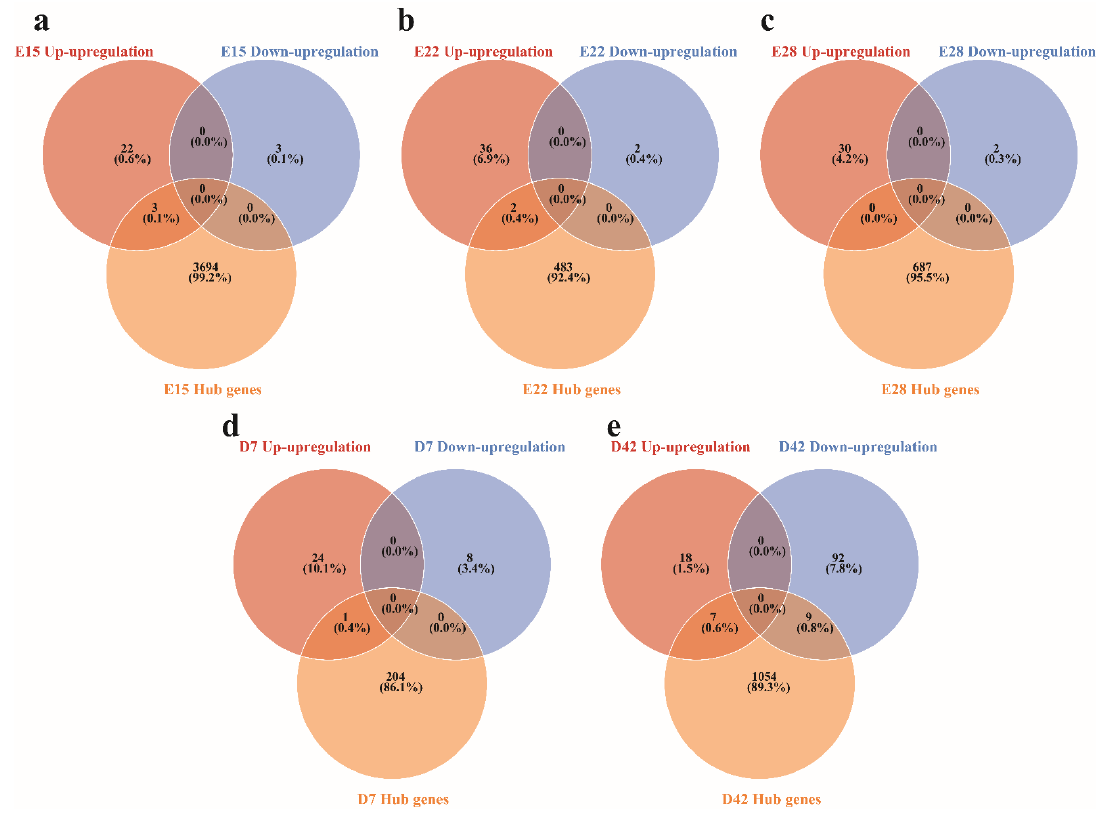
Figure 5. Genes associated with crest cushion in the different developmental stages. Venn analysis of DEGs and hub genes in the E15 ( a ), E22 ( b ), E28 ( c ), D7 ( d ), and D42 ( e ) stages.